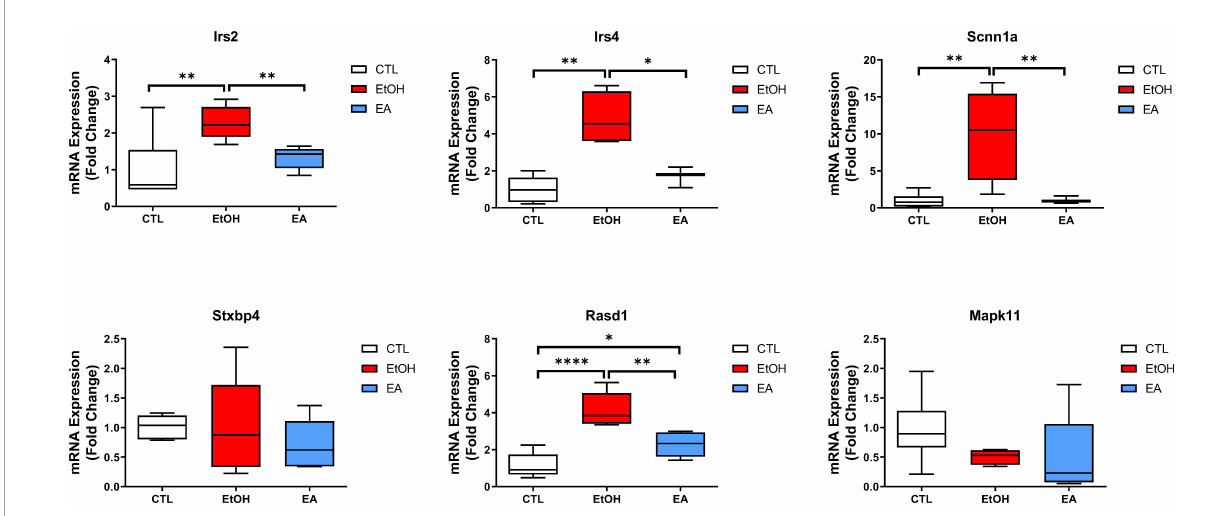
FIGURE6 Validation of TRAP-seq results on selected genes. qRT-PCR analysis of six genes selected from Insulin Receptor Signaling pathway (Irs2, Irs4, Scnn1a, Stxbp4, and Rasd1) and Chemokine Signaling pathway (Mapk11). Relative expression (Fold Change) is compared between TRAP_EtOH/TRAP_CTL and TRAP_EtOH + ABT-888/TRAP_CTL, respectively, using the mean fold-change for Irs2 (FC = 2.28; p = 0.0093, FC = 1.33; p = 0.43), Irs4 (FC = 4.82; p = 0.0011, FC = 1.70; p = 0.19), Scnn1a (FC = 9.86; p = 0.0075, FC = 0.95; p = 0.95), Stxbp4 (FC = 1.04; p = 0.96, FC = 0.72; p = 0.15), Rasd1 (FC = 4.17; p < 0.0001, FC = 2.29; p = 0.02), and Mapk11 (FC = 0.51; p = 0.15, FC = 0.50; p = 0.25). Results are represented as the mean fold-change normalized to the geometric mean of the housekeeping genes and error bars indicate the range of relative expression calculated using 2 - ((cid:49) (cid:49) Ct ± standard deviation ) . ∗ p < 0.05, ∗∗ p < 0.01, ∗∗∗∗ p <